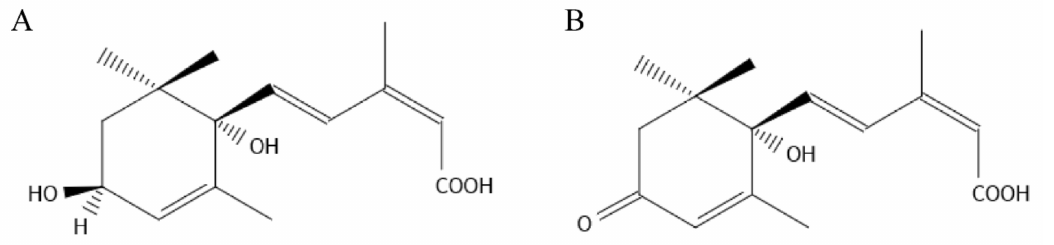
Figure 1. The chemical structures of 1 (cid:48) ,4 (cid:48) - trans -diol-ABA ( A ) and ABA ( B ). The adaptability of plant stress is primarily achieved by the regulation of gene ex- pression. Therefore, one of the main methods to study whether a new compound can induce plant stress resistance is to explore its effects on the expression of related genes. ABA-mediated stress response is the main way in which plants tolerate stress. Plant have developed a complex gene regulatory network for the signal transduction of ABA. First, the stress-induced 9- cis -epoxycarotenoid dioxygenase (NCED) catalyzes the final rate limiting step that enhances the biosynthesis of ABA [18]. The response to ABA is initiated by a signaling pathway, which activates kinase cascades. ABA binds to a family of receptor proteins (pyrabactin resistance1 (PYR1)/PYR1-like (PYL)/regulatory components of ABA receptors (RCAR)) and promotes the formation of a complex of PYR/PYL/RCAR proteins and phosphatase 2Cs (PP2Cs). In the absence of ABA, sucrose non-fermenting 1-related protein kinase 2(SnRK2) protein kinases remain dephosphorylated; whereas, in the pres- ence of ABA, ABA-bound receptors sequester PP2Cs, allowing the phosphorylation of SnRK2 and subsequent activation of ABA-responsive element binding proteins/factors (AREBs/ABFs) by phosphorylation [19]. The promoter of ABA-responsive genes possesses ABA-responsive elements (ABRE), which can bind to ABRE-binding proteins (ABREBPs) and activate transcription under ABA stimulation [20]. In addition, several transcription factors (TFs) of the bZIP, MYB, MYC, NAC, ERF, WRKY, and DREB protein families regu- late gene expression in an ABA-dependent manner [21–25]. Typically, ABA-induced genes primarily encode the proteins associated with dehydrins and the enzymes that detoxify re- active oxygen species, enzymes of compatible solute metabolism, a variety of transporters, protein kinases and phosphatases, and the enzymes involved in phospholipid signaling. ABA suppressor genes encode proteins associated with growth, including cell wall, ribo- somal, plasma membrane, and chloroplast proteins [20]. Whether 1 (cid:48) ,4 (cid:48) - trans -diol-ABA also induces the expression of these ABA-related genes or other potential genes, thereby regulating plant tolerance to adversity stress, remains